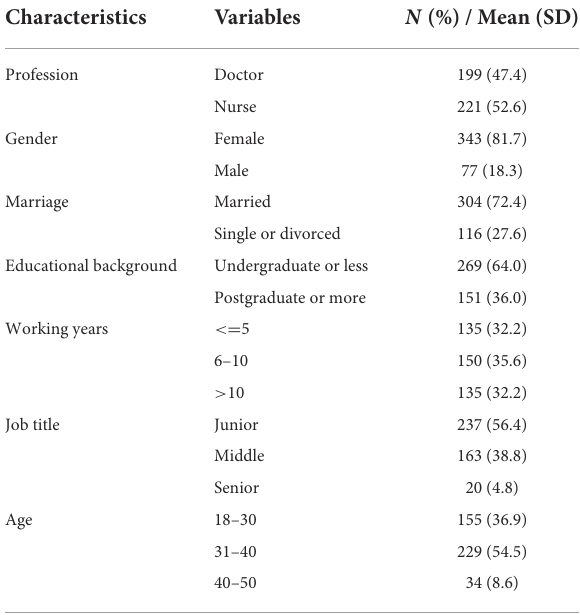
TABLE 1 Demographic characteristics of the